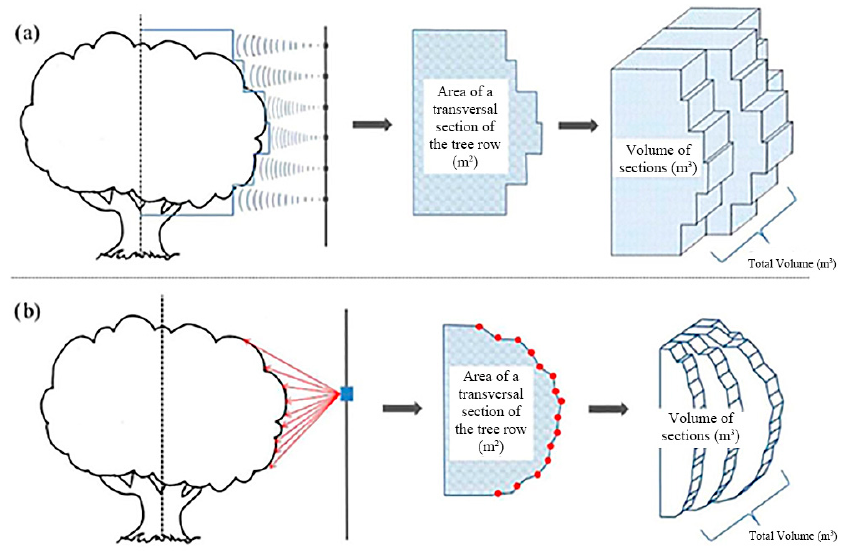
Figure 1. Measurement of target volume with ultrasonic ( a ) and LiDAR ( b ) sensors [22].